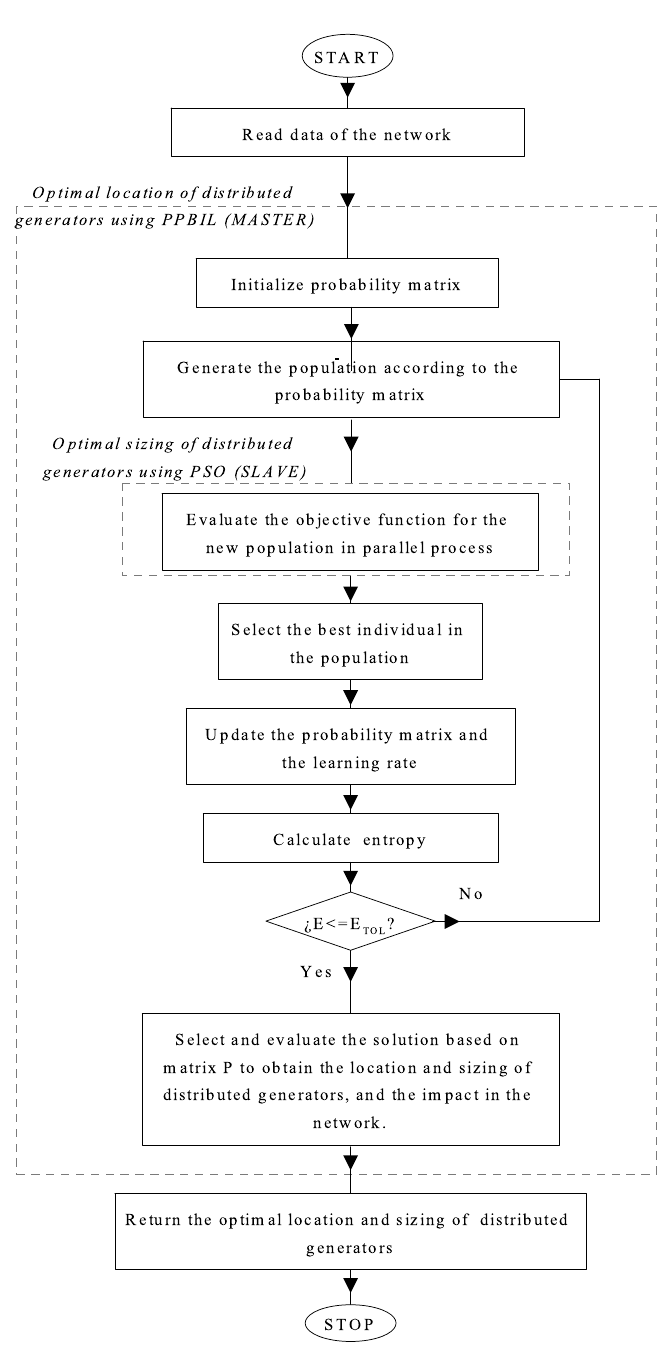
Figure 5. PPBIL-Particle Swarm Optimization (PPBIL-PSO) master-slave